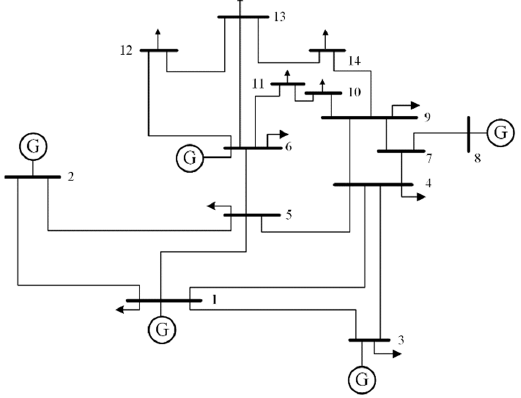
Figure 3. IEEE 14-bus test system single-line diagram. Table 4. Results of OPF for IEEE 14-bus test system on Case 1.